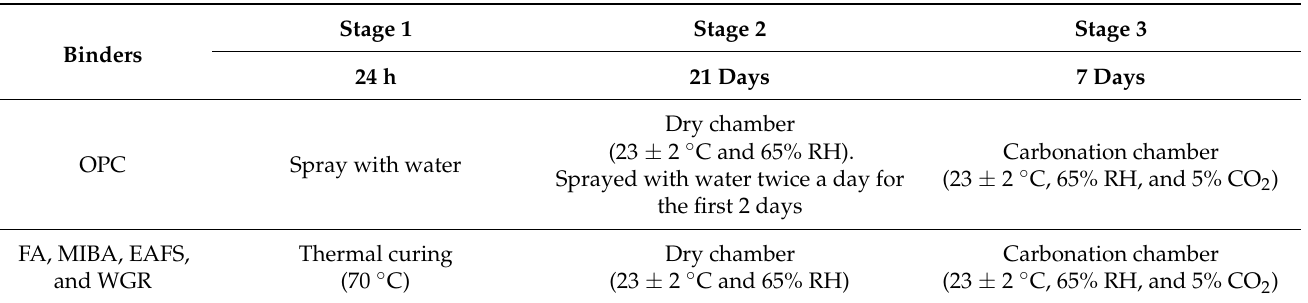
Table 3. Curing stages and